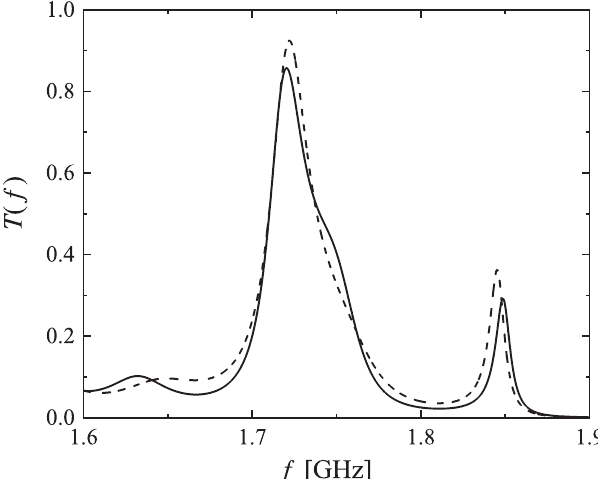
Fig. 8. Comparison of optimized transmission rate, T ( f ), and target function, T target ( f